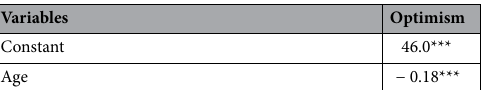
Table 5. OLS estimates with optimism as dependent variable and age and a constant as regressors. ***p < 0.001.